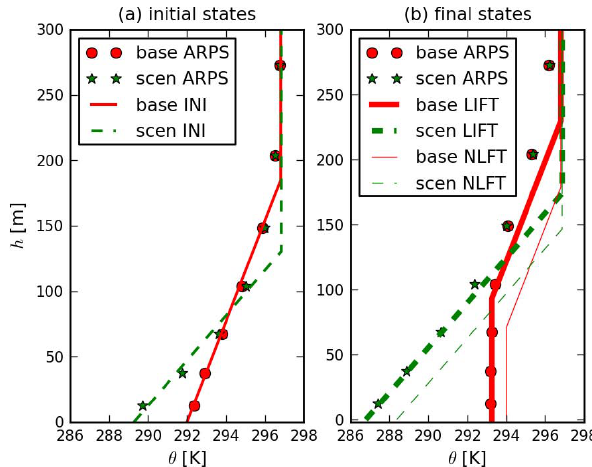
Fig. 13. The same as in Fig. 12, except that the stability of the initial profiles for the base and scen case are now reduced by a factor two.